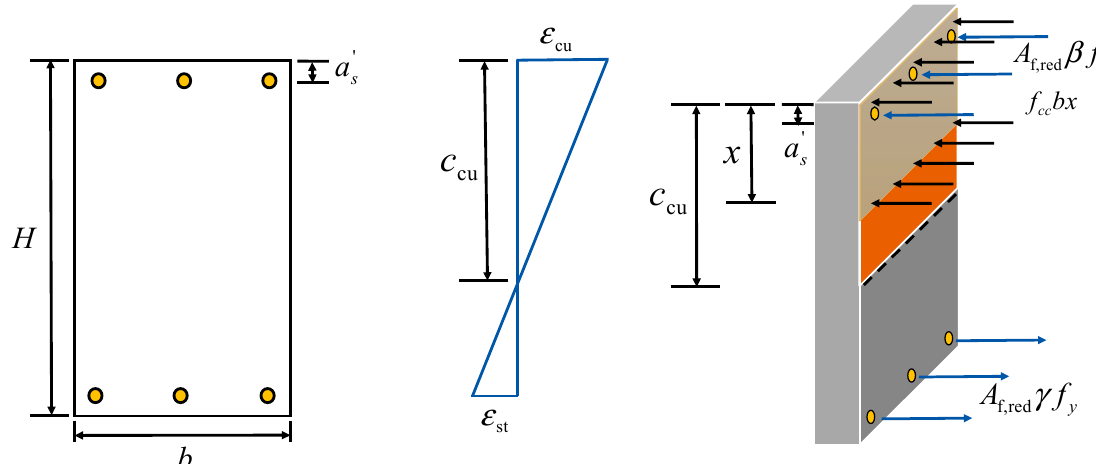
Figure 5. Distribution of stress and strain in the pure bending section. c cu : the height of compression zone in concrete; x : the equivalent rectangle height of the compression zone in concrete; ε cu : the ultimate compression strain of concrete; a (cid:48) s : the distance between the resultant force point of reinforcement and compression edge of the section; ε st : the ultimate tensile strain of the steel